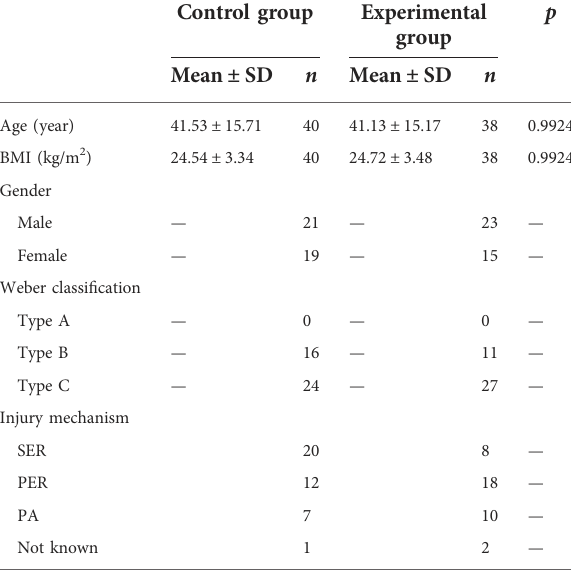
TABLE 1 Demographic characters and diagnosis of trans-syndesmotic screw fi xation (control) group and deltoid ligament repair (experimental)